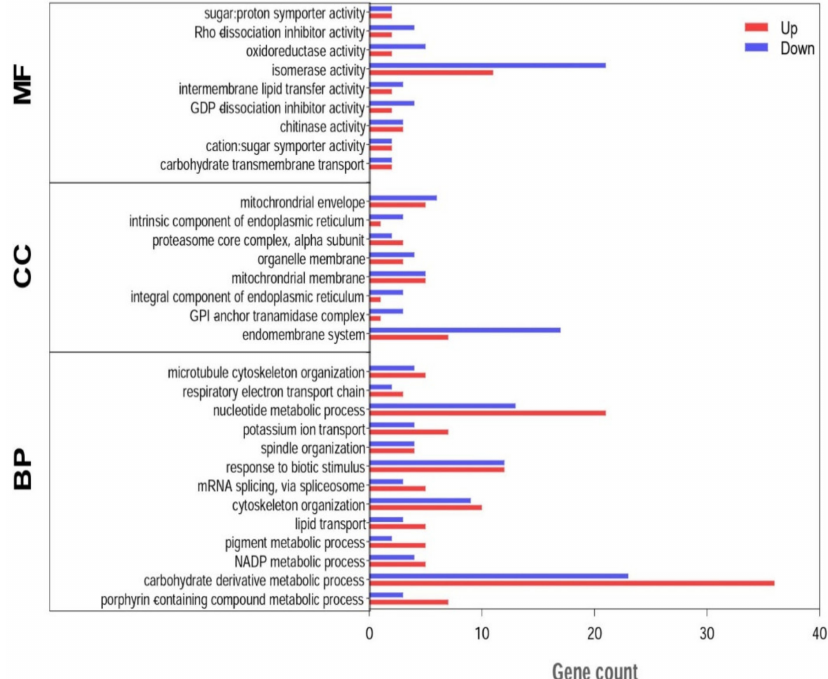
Figure 4. The classification of GO enrichment of DEGs identified in prostrate and bunch-type peanut. The Y-axis represents the number of genes annotated into the GO terms, and the X-axis represents enriched functional